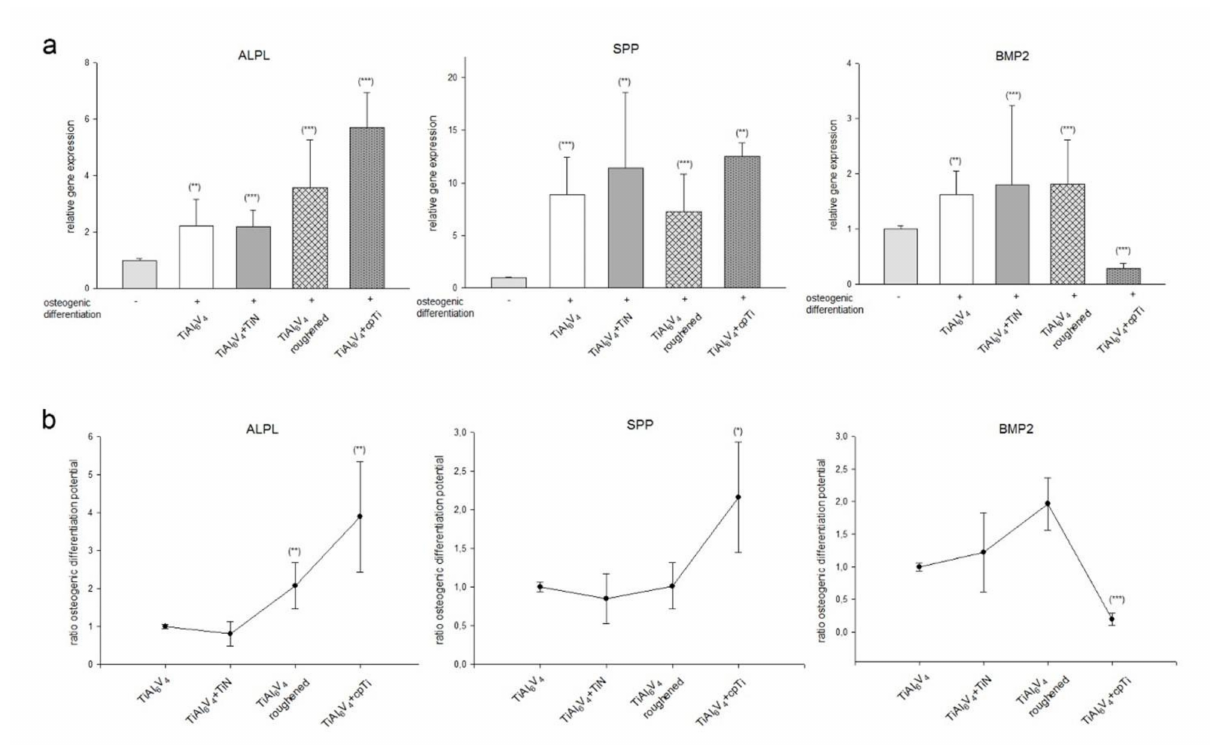
Figure 6. The expression of osteogenic markers in MSPCs seeded on different surface modified TiAl 6 V 4 discs. MSPCs were seeded on uncoated TiAl 6 V 4 , titanium nitride (TiN) coated, silver coated (Ag), a roughened surface, and pure titanium coated material discs and the cells were induced for an osteogenic differentiation over 21 d. After RNA isolation the relative expression of ALPL, SPP, and BMP2 were analysed using RT-qPCR. Undifferentiated MSPCs (-) served as references (ratio = 1) (mean ± SD; n = 9, measured in triplicates). ( a ) shows the change in the expression of important osteogenic differentiation markers on the TiAl 6 V 4 surfaces, ( b ) displayed the changes within the material groups in relation to the untreated TiAl 6 V 4 group. Statistical significances are defined as follows: *** p < 0.001; ** p < 0.01; * p <